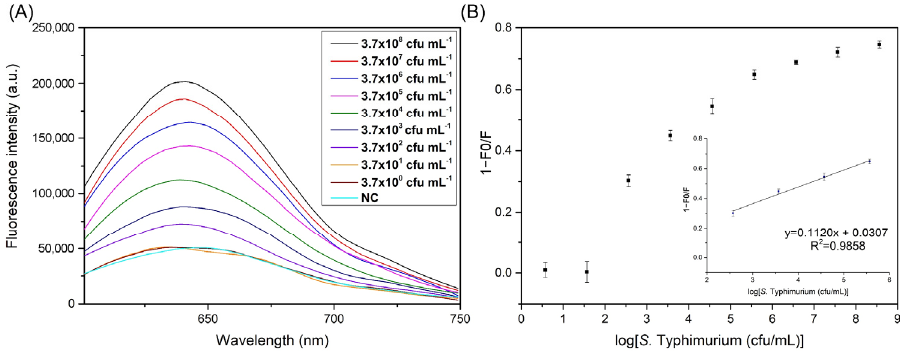
Figure 5. Sensitivity detection of the pure culture S. Typhimurium by established aptasensor. ( A ) The fluorescence emission spectra response with the concentrations of pure culture of S. Typhimurium ranged from 3.7 × 10 0 to 3.7 × 10 8 cfu/mL. NC: negative control. ( B ) The relationship between the fluorescence ratio (1 − F0/F) and the logarithm of the concentration of S. Typhimurium. Inset: the linear relationship between the (1 − F0/F) and the logarithm of the concentration of S. Typhimurium. The error bars show the standard deviations of 3 repetitive experiments. Table 2. Comparison with the previously reported methods for S. Typhimurium detection.